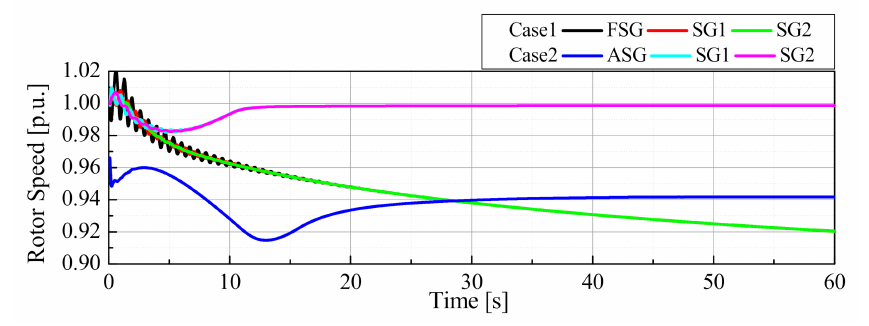
Figure 19. ASG and FSG output (Pumping Operation).